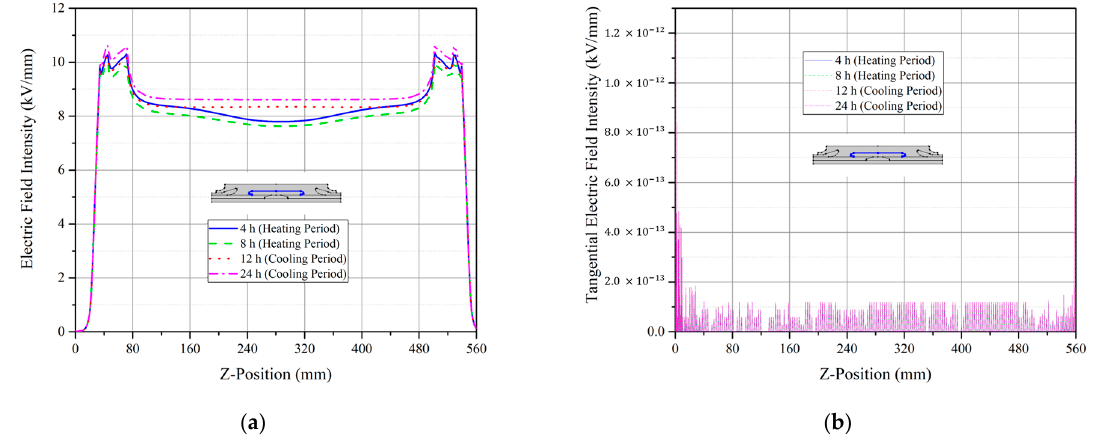
Figure 8. Time-varying electric field distribution at central deflector/SiR interface: ( a ) Electric field intensity at the interface; ( b ) Tangential electric field intensity at the interface.